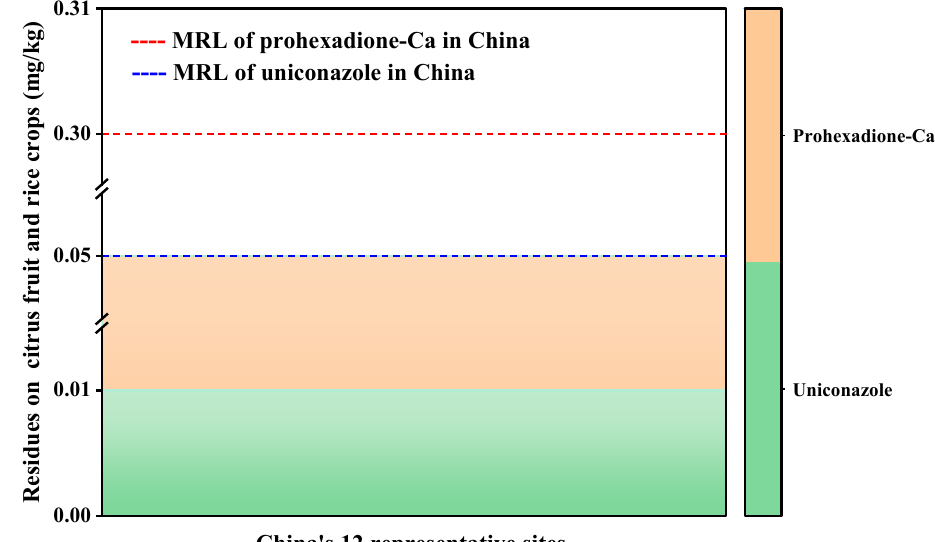
Figure 3. Residues and MRLs of prohexadione-Ca and uniconazole at 12 representative sites.